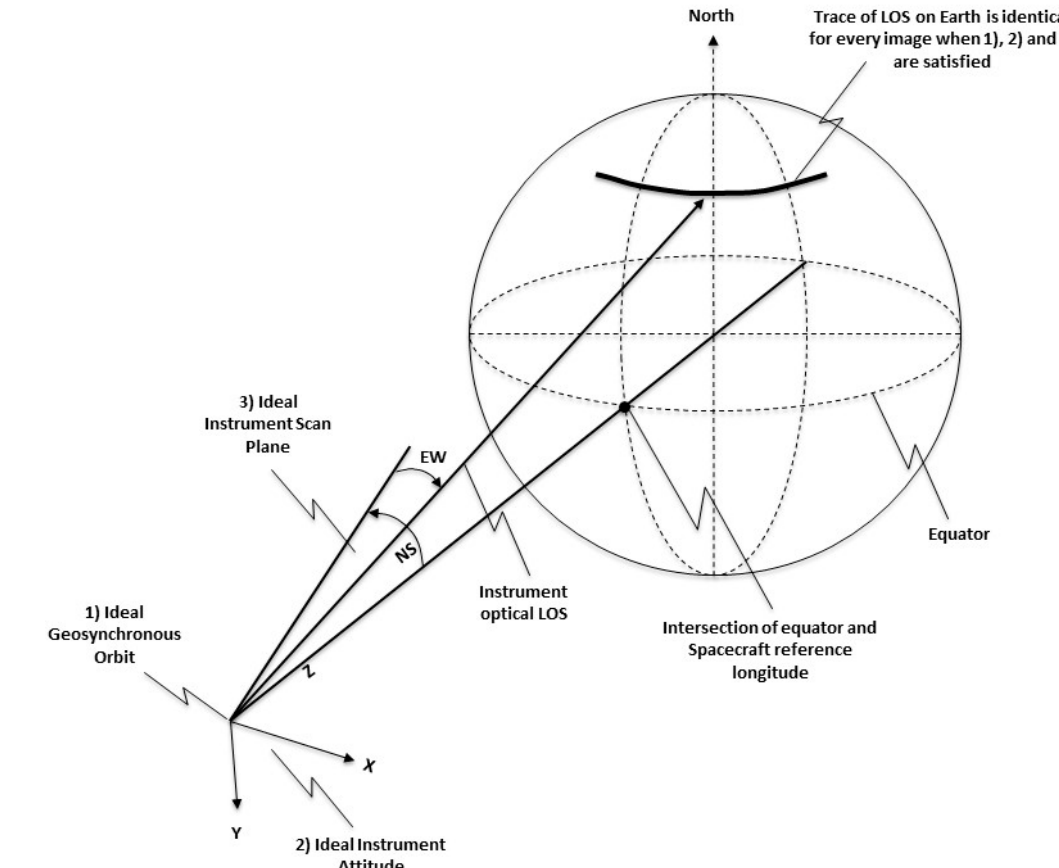
Figure 11. Fixed-grid coordinates are defined by an idealized scanning system where the NS angle elevates the EW-scan plane with respect to the equator [11]. This definition follows that of the legacy GOES-NOP system, but other operators such as EUMETSAT and JMA use a convention where the order of rotations is swapped.